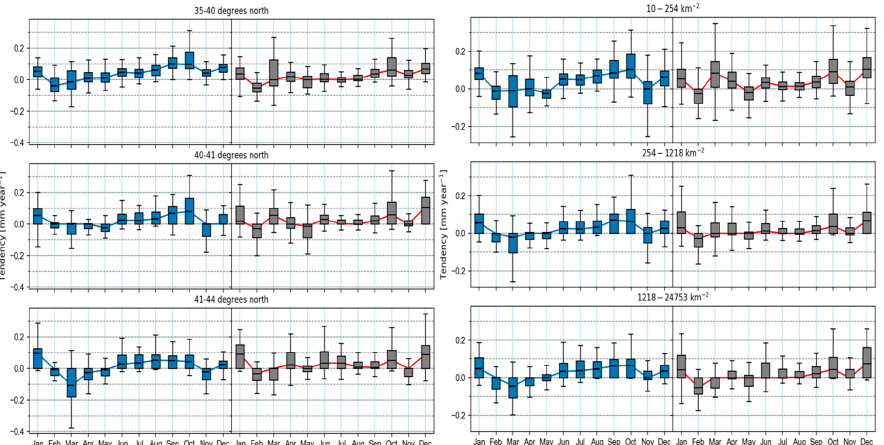
Figure 7. Three-day peak flow tendency by latitude (left) and area (right) for the model results (blue line) and US Geological Survey (USGS) streamflow Geospatial Attributes of Gages for Evaluating Streamflow II (Gages II) (red).